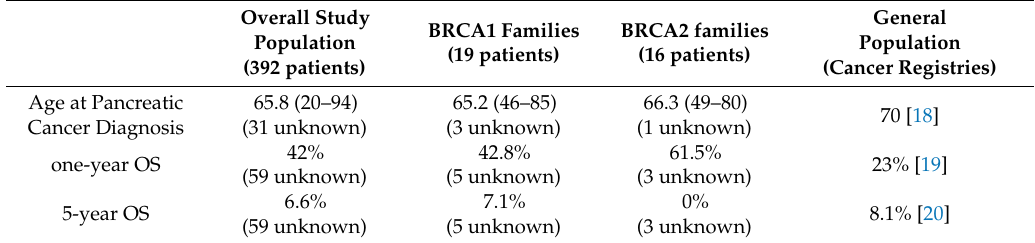
Table 3. Pancreatic cancer characteristics in our sample and in the general population